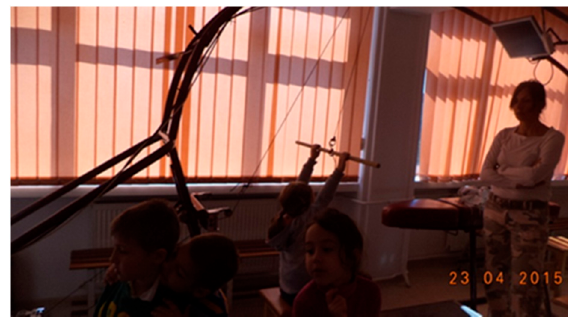
Figure 2. Execution with visual stimulus, ERGOSIM. When testing T2, the difference from T1 was that the subjects received the information that the executed movement must draw a line as close to the model (Figure 3—yellow graph) 10 times. They did not receive any explanation as to how the movement should be done (how hard or slow to pull or how to reach their arms).